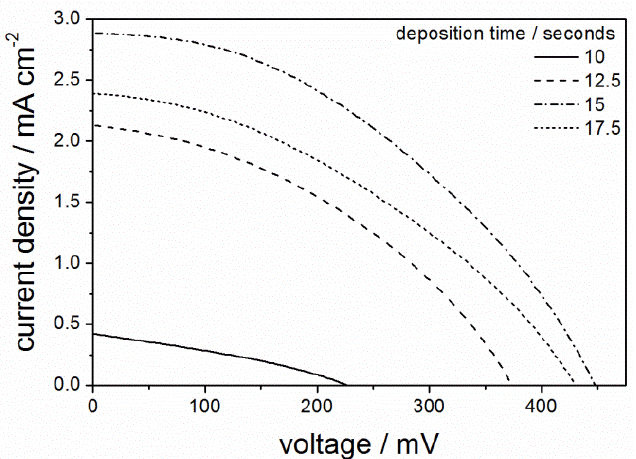
Figure 8. J - V -curves of D149-sensitized ZnO deposited into aged five-layer mesoporous ITO films prepared with PIB-PEO 20000 for different ZnO deposition